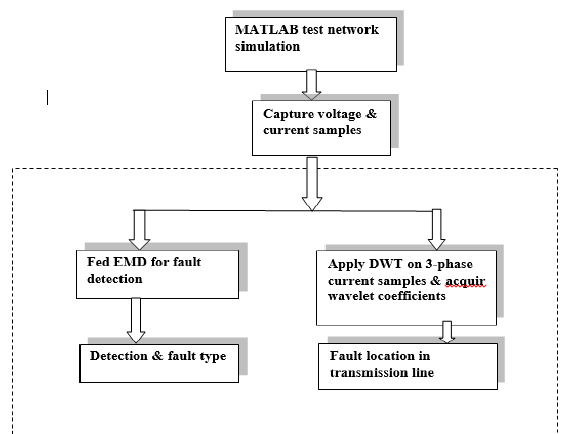
Figure 1. Block diagram of the proposed system using EMD and